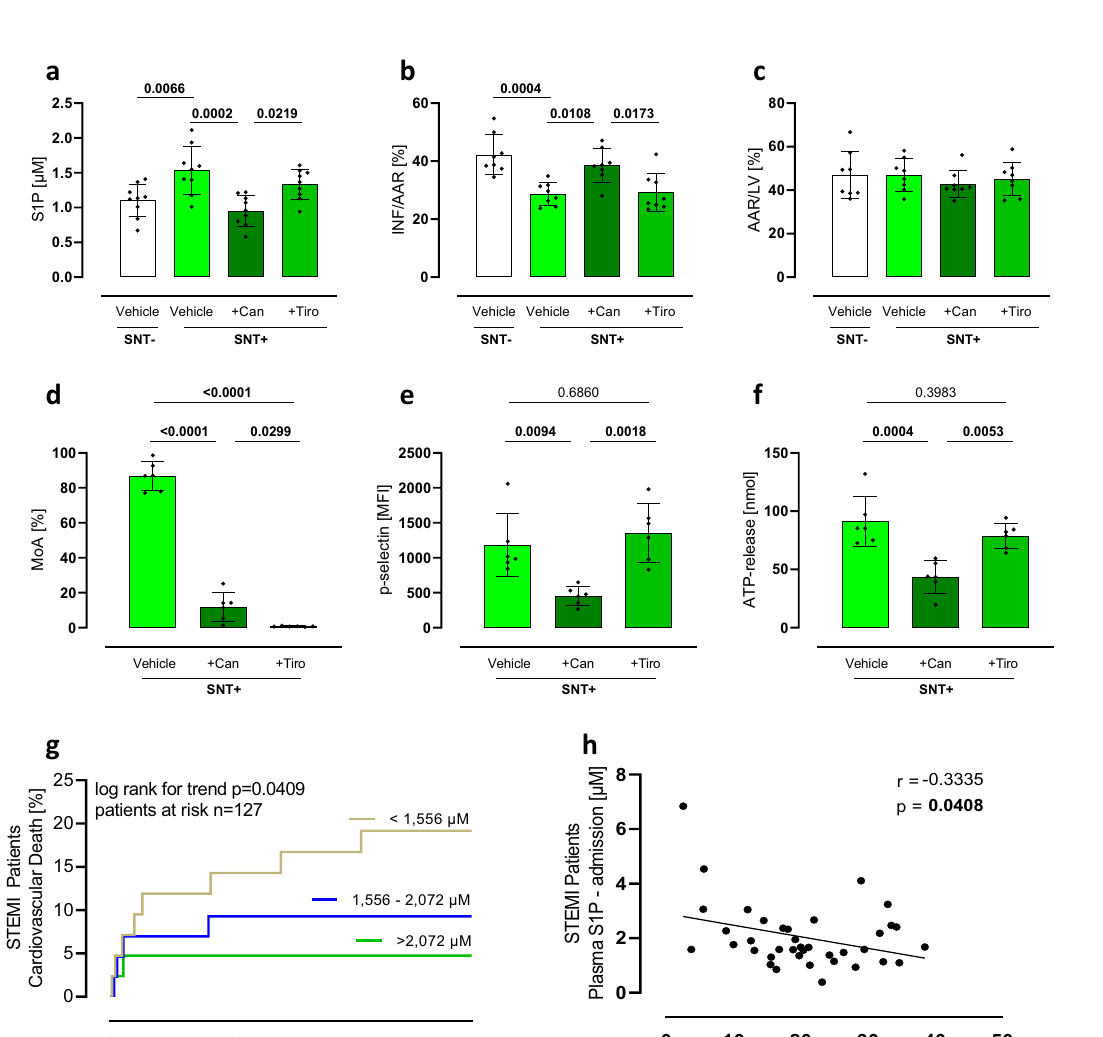
Fig. 2 | Platelet-derived S1P exerts cardioprotection through the cardiomyo- cyte S1P receptor 1 (S1P 1 ) and de fi ciency of platelet S1P transporter major facilitator superfamily domain containing 2B ( Mfsd2b ) leads to increased infarct size in vivo. a SNT+ leads to decreased infarct size (IS [%LV]), b higher left ventricular pressure gradient (DP), and c lower left ventricular end-diastolic pres- sure (LVEDP) in a model of Langendorff-perfused hearts. This was blunted by pharmacological inhibition of S1P receptor 1 via W146 treatment (S1P 1 ; two-way ANOVA, Vehicle n SNT − =10, n SNT+ =8, W146 n SNT − =7, n SNT+ =5). d Accordingly, genetic cardiomyocyte de fi ciency of S1P 1 ( S1P 1 α MH CCre − ) abrogated bene fi cial SNT+ effects in Langendorff-perfused hearts in terms of infarct size, e left ventricular pressure gradient (DP) and f LVEDP (two-way ANOVA, S1P 1 α MH CCre − n SNT − =6, n SNT+ =5, S1P 1 α MHCCre+ n SNT − =6, n SNT+ =5). g InvivoAMIexperimentsintheseanimals revealed preserved cardioprotection in littermate controls but blunted reduction of infarct size (INF/AAR) in cardiomyocyte-speci fi c S1P 1 de fi ciency (Two-way